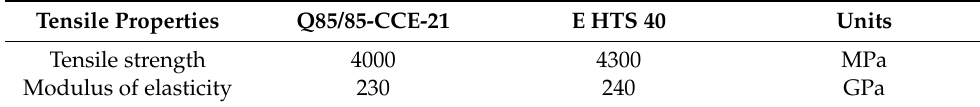
Table 3. Material data of carbon reinforcement.